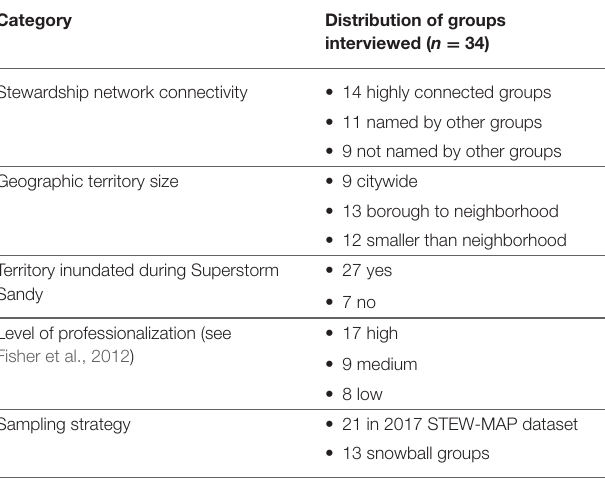
TABLE 1 | Characteristics of stewardship groups